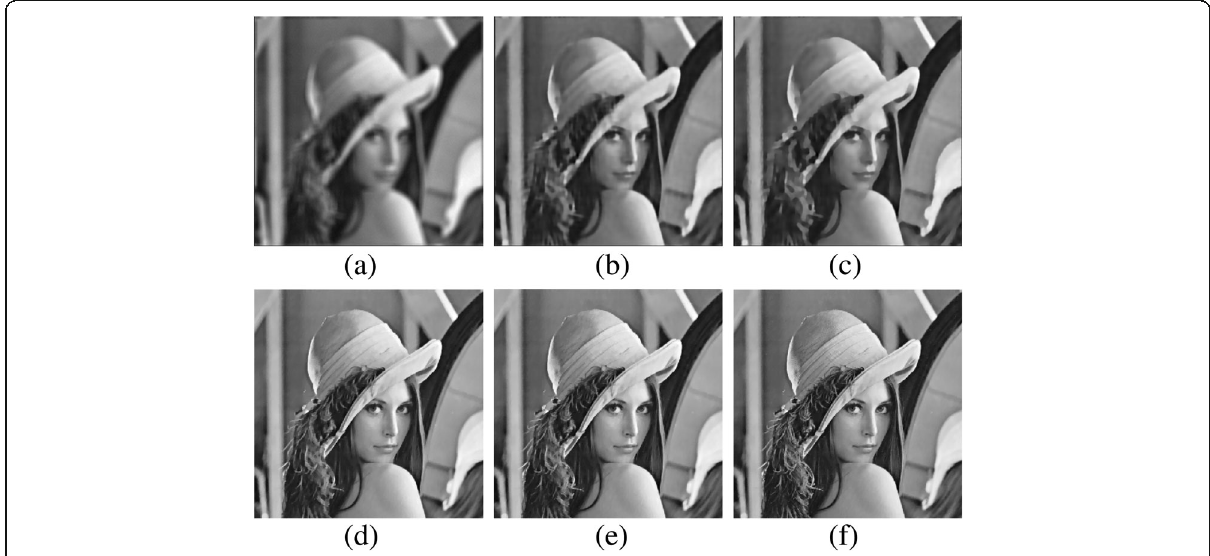
Fig. 7 Experiments on the blurry and noisy image of “ Lena ” (512 × 512). a Blurry and noisy (PSNR = 19.31). b The local TV [5] (PSNR = 21.22, t = 4.32 s). c GOS_TV [15] (PSNR = 23.09, t = 10.93 s). d The local/nonlocal TV [26] (PSNR = 24.57, t = 20.21 s). e The nonlocal TV [8] (PSNR = 25.69, t = 14.34 s). f The proposed model(PSNR = 27.53, t = 13.02